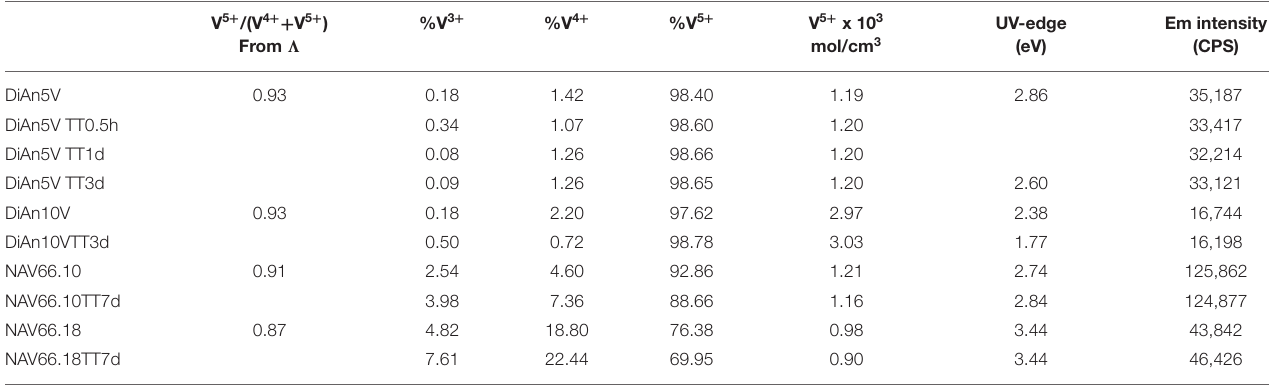
Estimated percentage of each single redox species is reported, along with the concentration per volume unit of the oxidized species V 5 + (mol/cm 3 ). The results below assumed that the local environment of V did not change significantly with glass composition and that the extinction coefficient of Leister et al. (1999) can be kept constant. UV-edge energies (eV) and